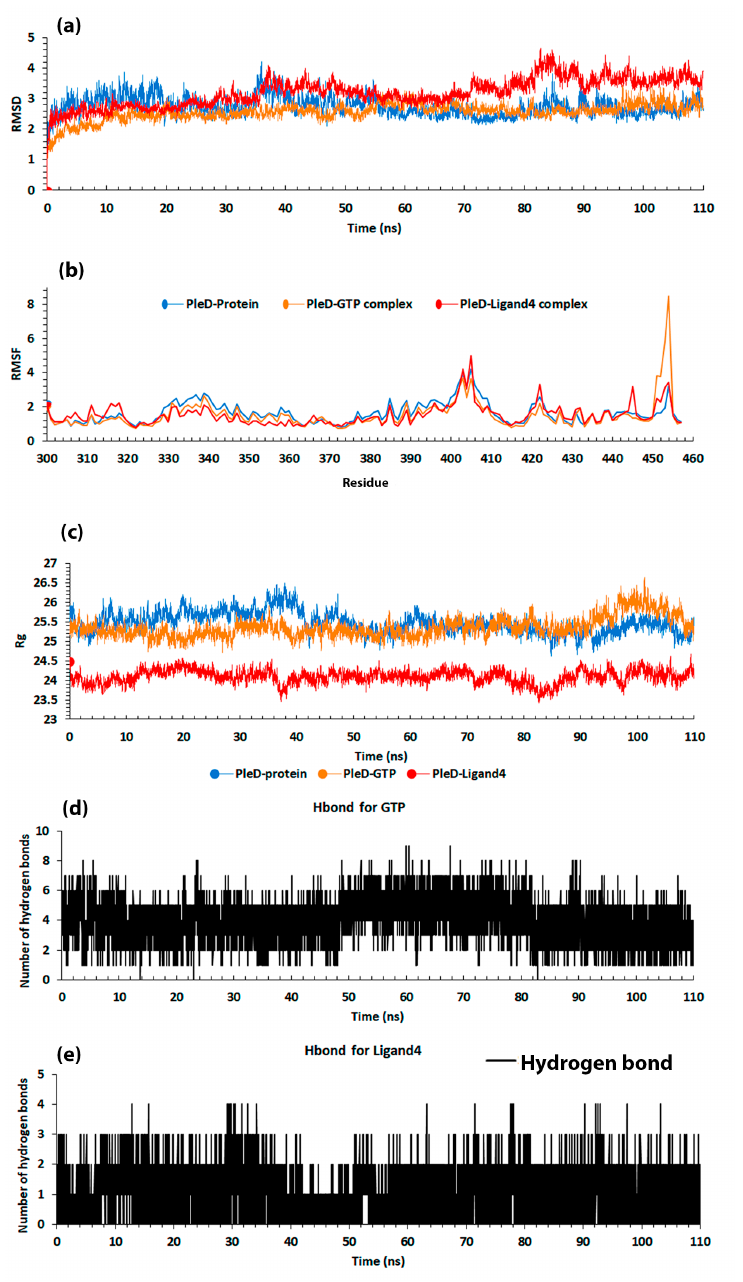
Figure 9. Analysis results from the second production of 110 ns, ( a ) RMSD in angstrom, ( b ) RMSF in angstrom, ( c ) Radius of gyration (Rg) in angstrom, ( d ) Hydrogen bonds for GTP, and ( e ) Hydrogen bonds for